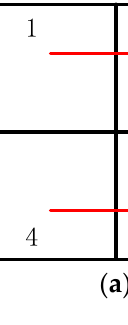
Figure 5. n th-order Hilbert curve, ( a ) n = 1, ( b ) n = 2. The position and direction of the starting point of a Hilbert curve determines the traversal order of the curve in space. Therefore, combining the position and direction of the starting point, we will get eight kinds of initial 1-order Hilbert curves, as shown in Figure 6.